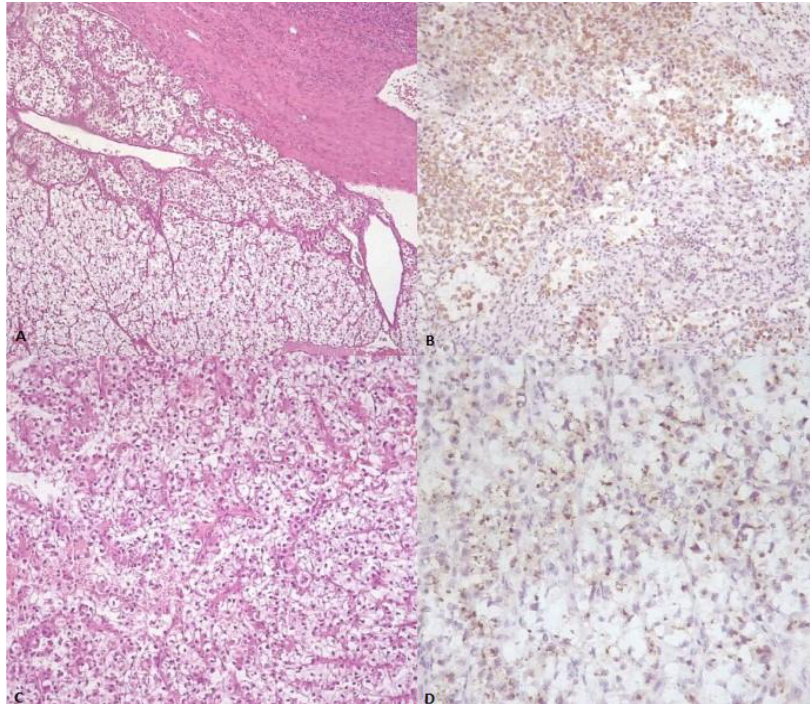
Figure 1. ( A ) Low-power image demonstrating sheets of neoplastic cells with abundant clear cytoplasm (center), almost indistinguishable from normal adrenal gland tissue (bottom) (H&E stain). ( B ) The neoplastic cells stained positively with antibody against Melan-A. ( C ) Population of neoplastic cells showing round nuclei and abundant clear cell and eosinophilic cytoplasm, partially surrounded by thin and delicate, curved vessels (H&E stain). ( D ) The tumor cells exhibit focal granular cytoplasmic immunoreactivity for cathepsin K.